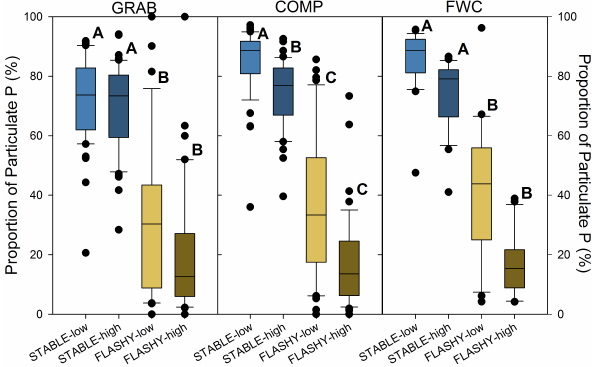
Figure 5. Contribution of particulate phosphorus (PP) to exported total phosphorus (TP). Left boxplots are based on instantaneous- grab sampling and linear interpolation estimation, centre boxplots are based on composite data, and the right boxplot on flow-weighted concentrations. Letters A, B, and C are used to display statistical groups according post hoc paired comparison analysis. The bound- ary of the box closest to zero indicates the 25th percentile, a line within the box marks the median, and the boundary of the box far- thest from zero indicates the 75th percentile. Whiskers above and below the box indicate the 90th and 10th percentiles. STABLE: low- flashiness Danish streams; FLASHY: Uruguayan flashy streams; low- and high-LUI: low and high land use